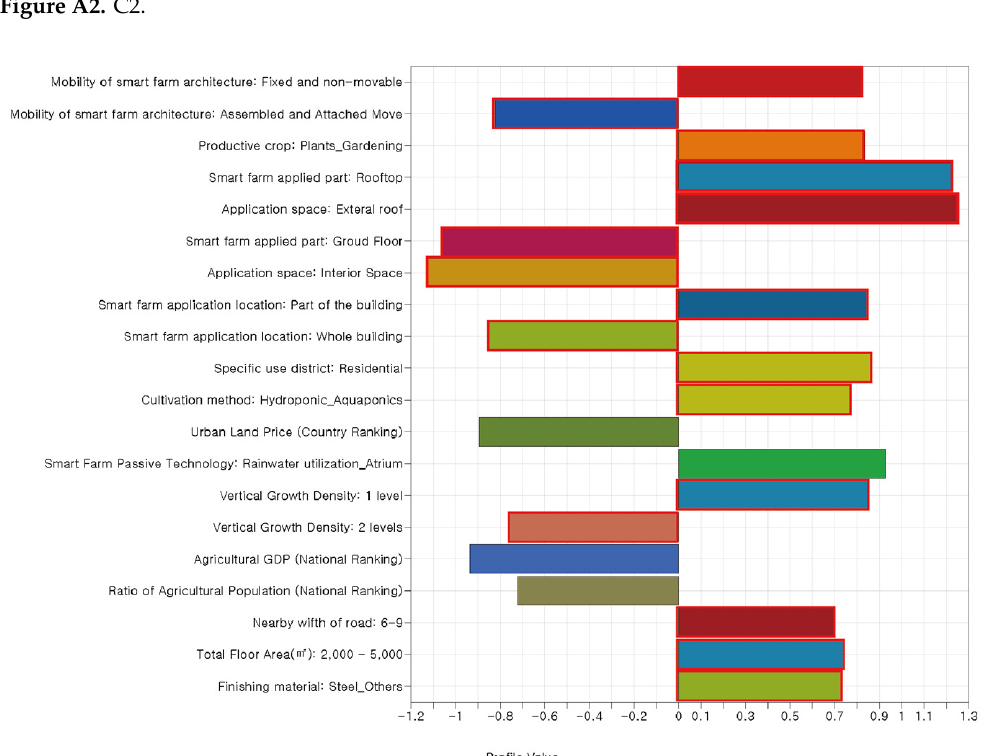
Figure A3. C3. Figure A3.